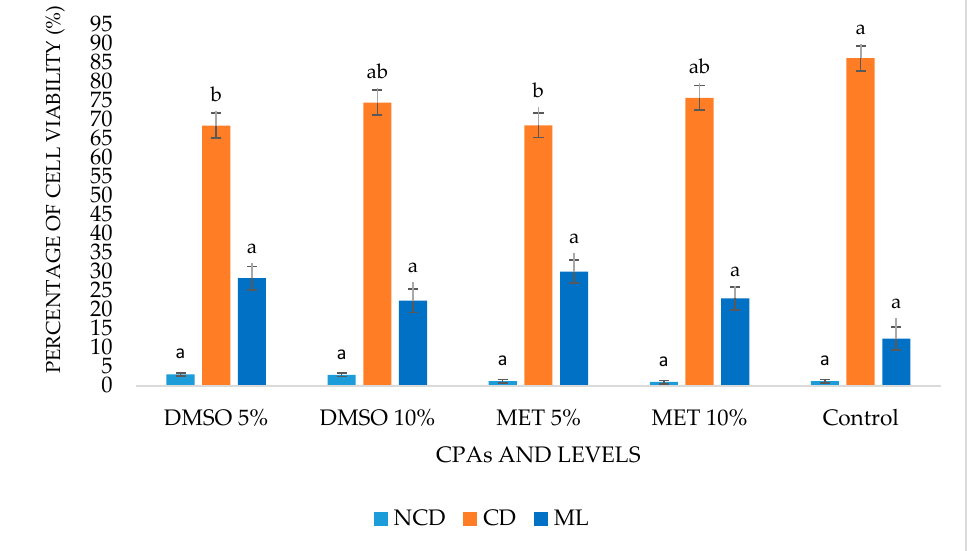
Figure 2. Percentage of cell viability of Scenedesmus sp. on day zero after thawing. No cell damage (NCD), with cell damage (CD) and marked lesions (ML) of the evaluated treatments. Different letters for the three criteria indicate significant differences ( p < 0.05).